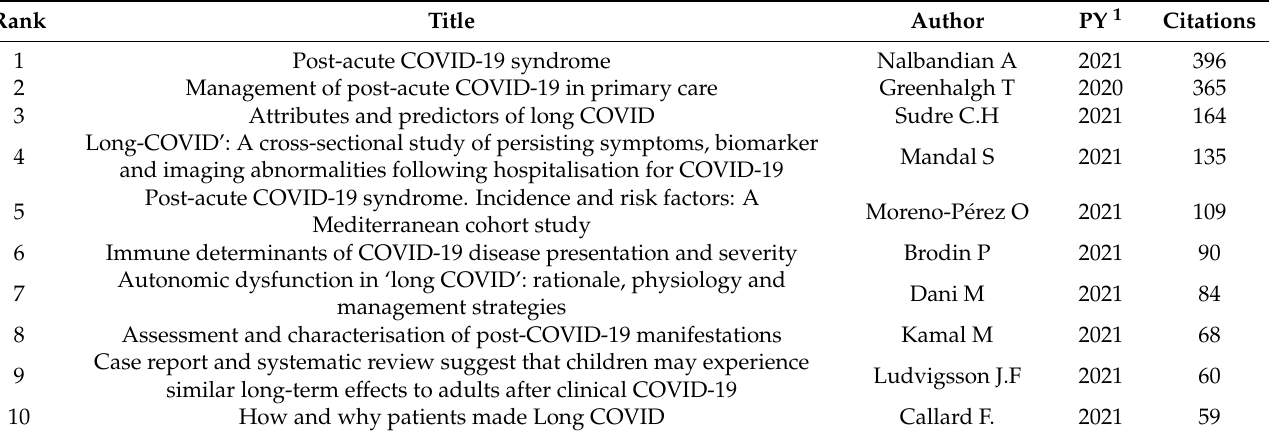
Table 3. The top 10 articles or reviews based on citations.